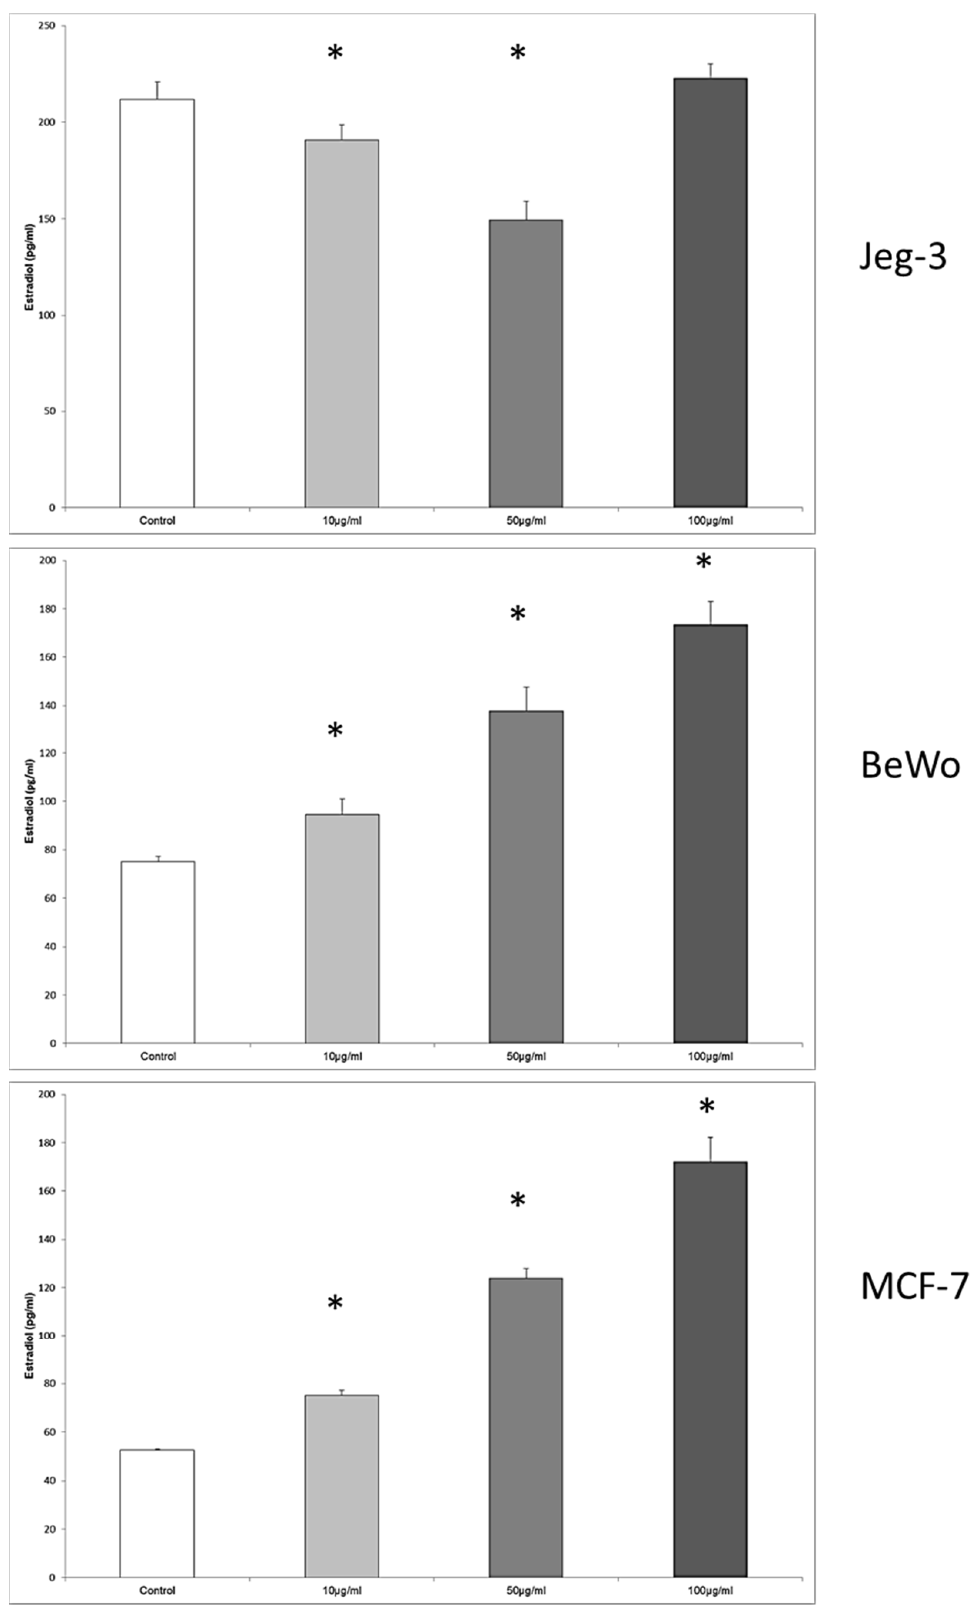
Figure 7. Estradiol concentration in the tissue culture medium of JEG ‐ 3, BeWo and MCF7 cells in the absence or presence of enterolactone. The effective enterolactone concentrations were 10 μ g/mL, 50 μ g/mL, and 100 μ g/mL. Significantly different observation are highlighted with an asterisk.